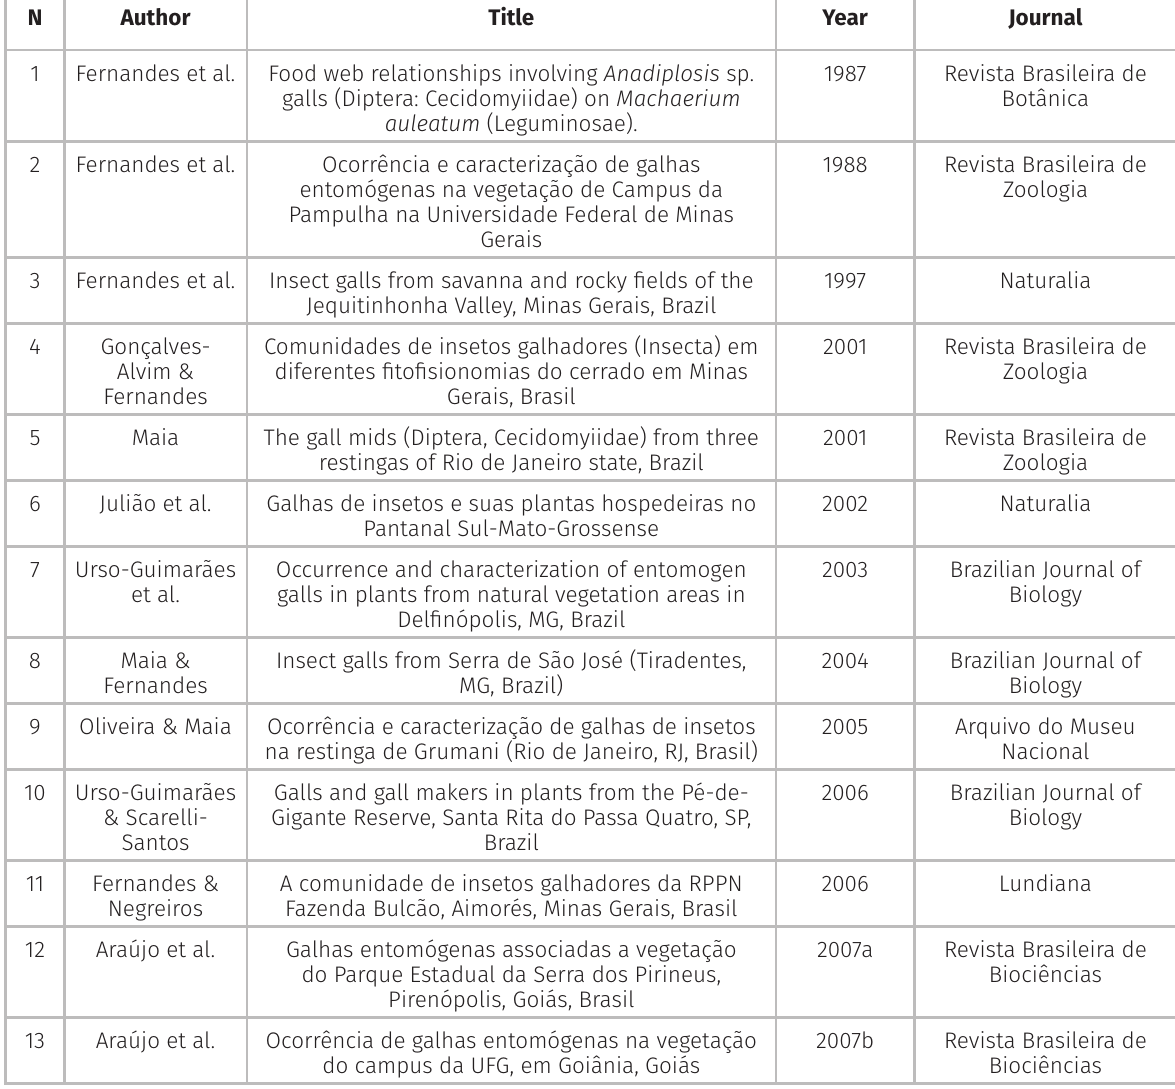
Table I. Articles concerning galls induced in Leguminosae in Brazil that were published in scientific journals between 1987 and 2018 and indexed on the Portal Platform of Periodicals CAPES